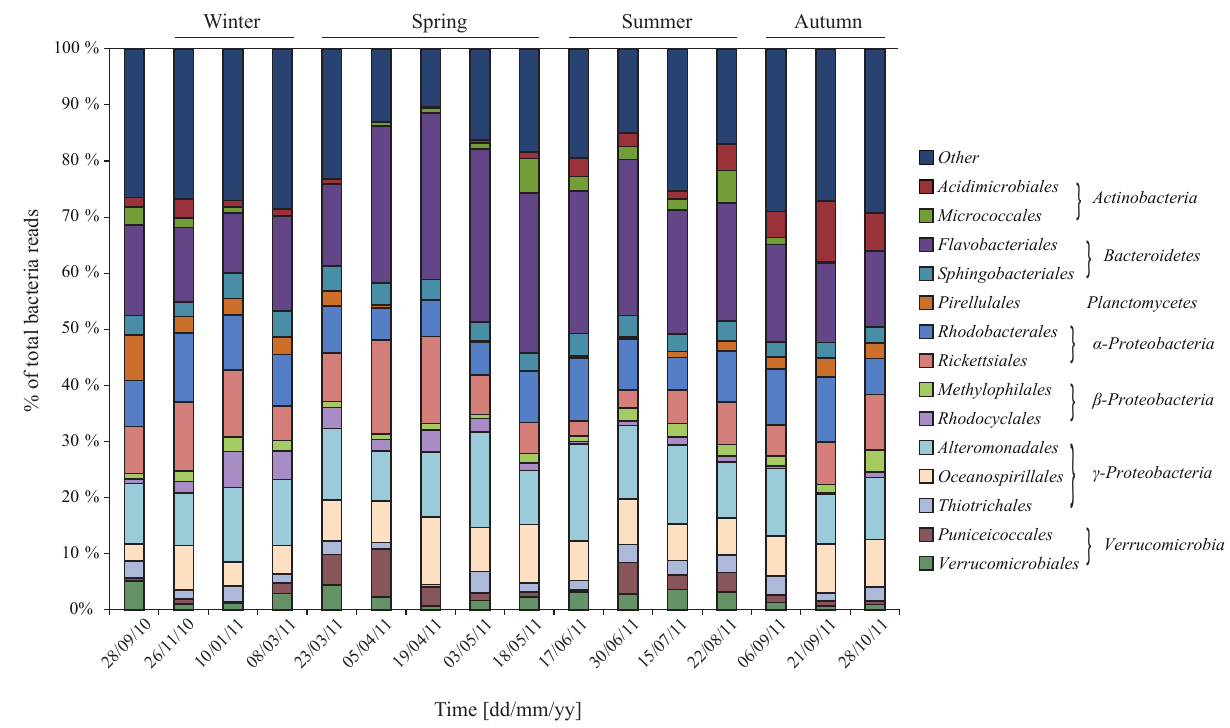
Figure 3. Order-level bacterial diversity and abundance in North Sea water based on the 16S rRNA gene sequence.